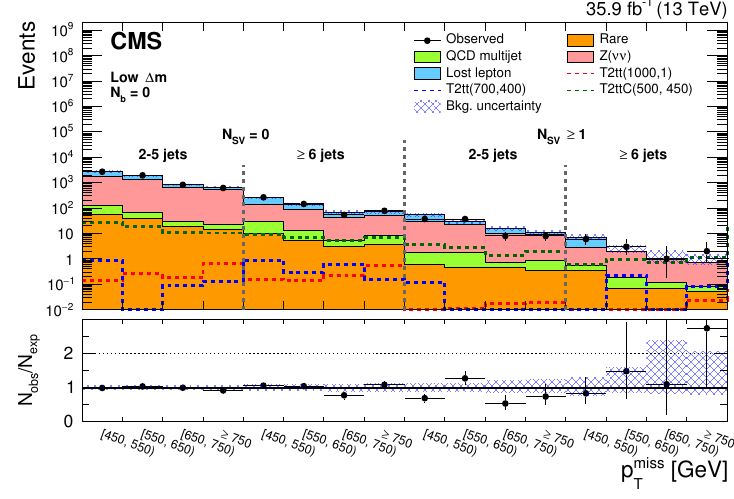
Figure 5 . Observed data events and SM background predictions for the low (cid:1) m search regions with N b = 0. Ratios of the observed to SM predicted event counts are shown in the lower panel of each plot. The shaded blue band represents the combined statistical and systematic uncertainties on the SM predictions. Units are